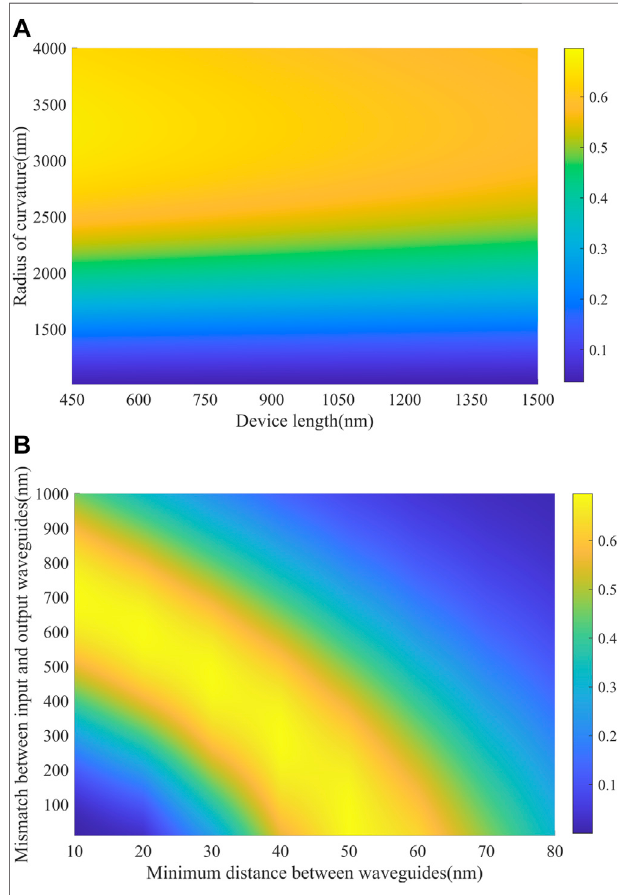
FIGURE 7 | Robustness of the geometrical parameters and the calculations at 35 THz, 0.7 eV. (A) Final transmission rate against the device length and the radius of curvature, with fi xed d min = 20 nm and mismatch δ = 550 nm . (B) Final transmission rate against different minimum distances d min and mismatch δ , with the fi xed length of the device L = 1 μ m and the radius of curvature R = 3.6 μ m